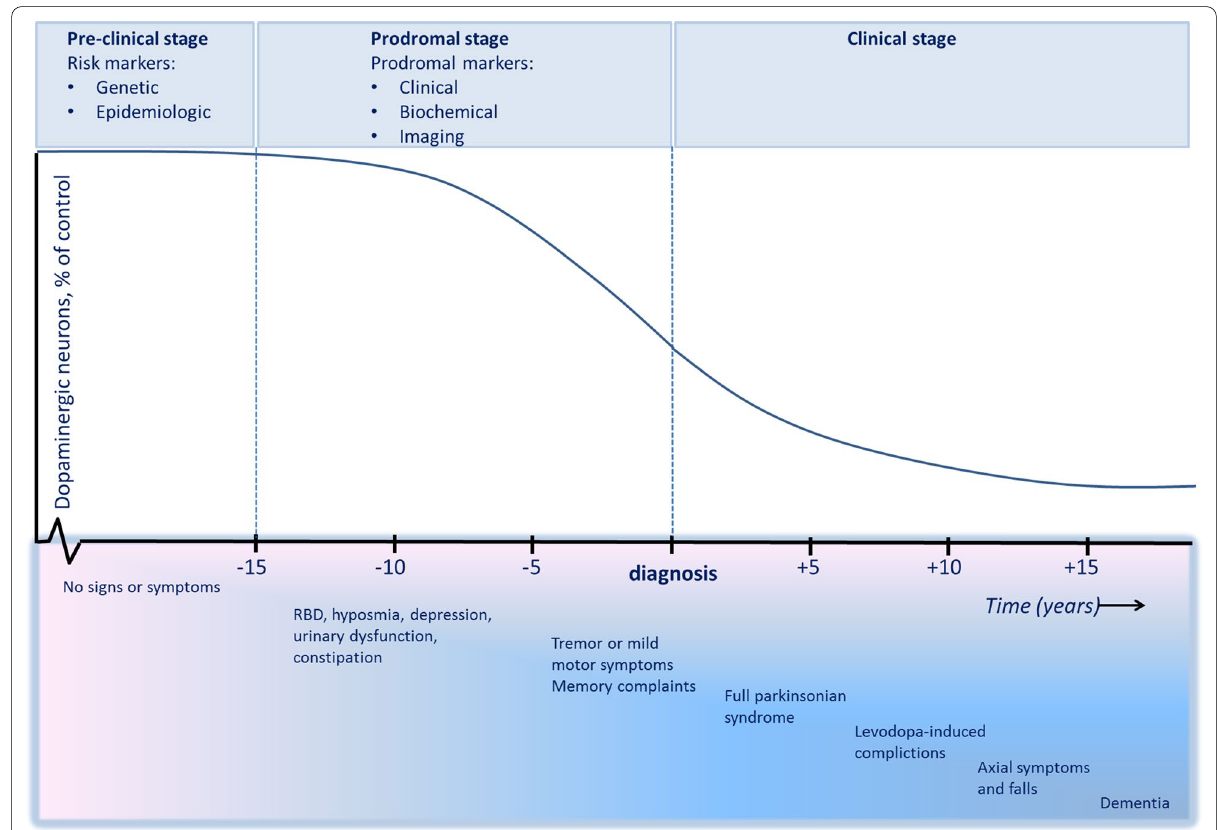
Fig. 1 Schematic of preclinical, prodromal and clinical stages in PD. The y-axis shows the percentage of dopaminergic neurons in the substantia nigra. The exact course of dopaminergic attrition is unknown and is provided here schematically. The x-axis depicts the number of years before (left) and after (right) diagnosis. The exact duration of the preclinical and prodromal stages is unknown. The order of prodromal symptoms may vary between patients and are mentioned here in random order. The disease course depicted in this schematic only applies to patients with the so-called ‘body-first’ subtype of Parkinson’s